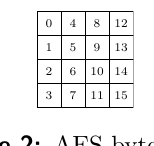
Figure 2: AES byte